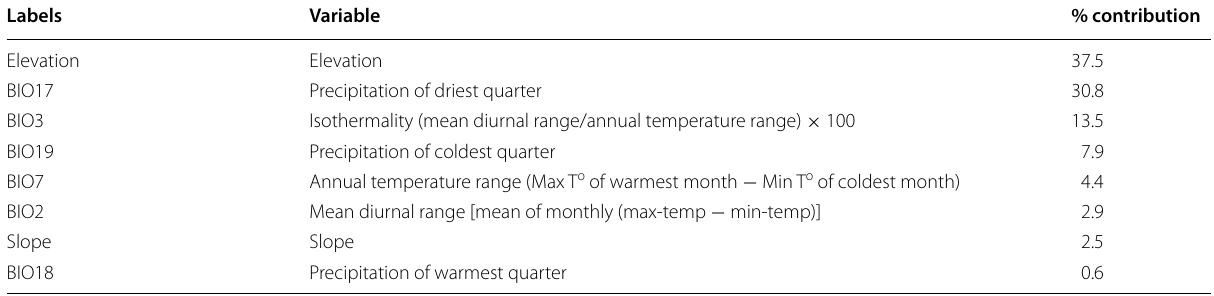
Table 3 Relative contribution of the variables in predicting species’